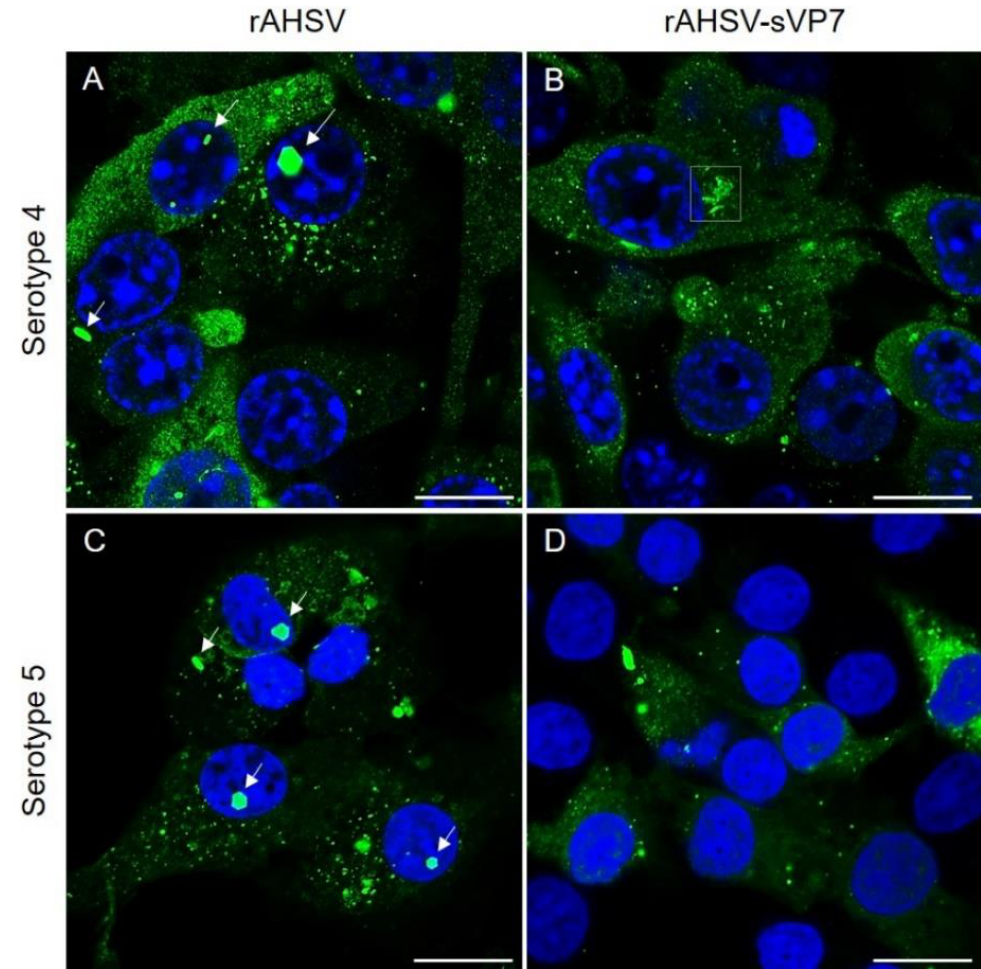
Figure 1. Intracellular VP7 distribution of recombinant reverse genetics-derived wild-type and mutant rAHSV of serotype 4 ( A , B ) and serotype 5 ( C , D ), respectively. Arrows indicate characteristic wild-type VP7 crystalline particles. Block indicates uncharacteristic VP7 tubules. BSR cell monolayers, seeded on coverslips, were infected at a MOI of 0.1 of each virus, incubated for 48 h, fixed and labelled as described in Section 2.5. VP7 was labelled with anti-VP7 guinea pig primary antibody and detected using Alexa Fluor 488 anti-guinea pig secondary antibody (green). Nuclei were stained with DAPI (blue). Scale bars represent 10 µm.